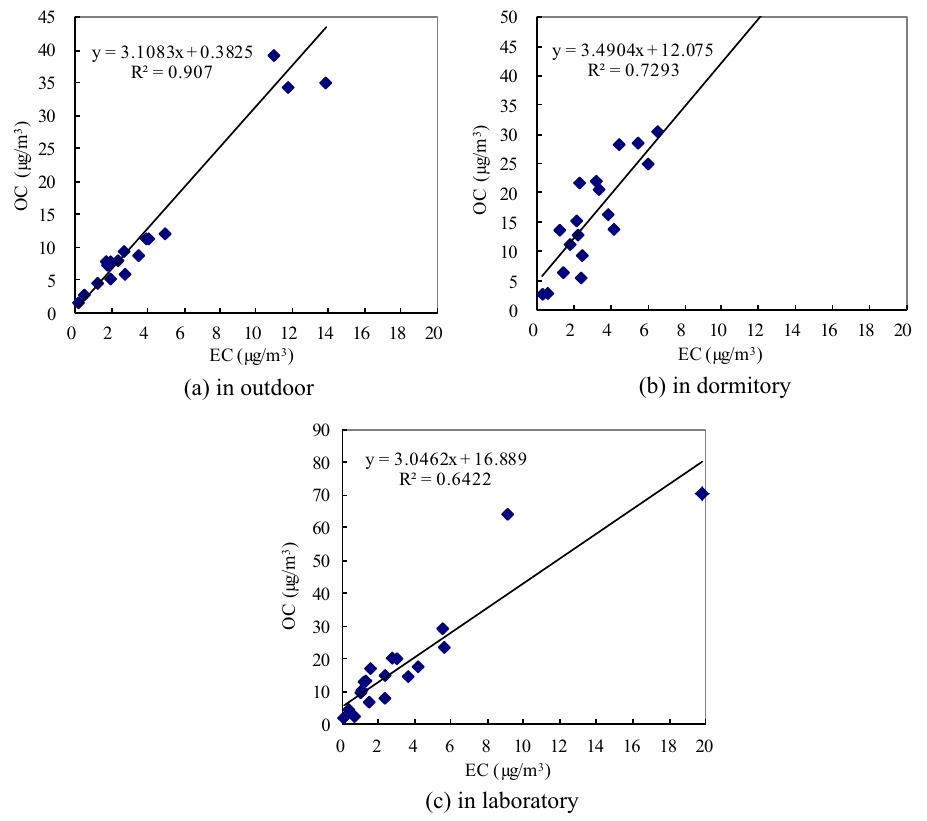
Figure 6. Correlation between OC and EC in indoor and outdoor.